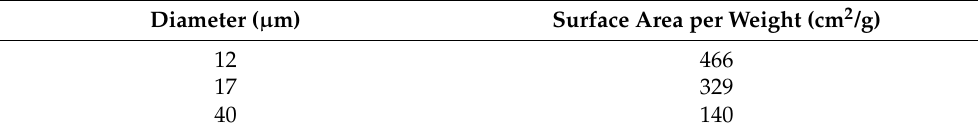
Table 4. Estimation of the surface area per weight for different sizes of the FeCrAl fibers.